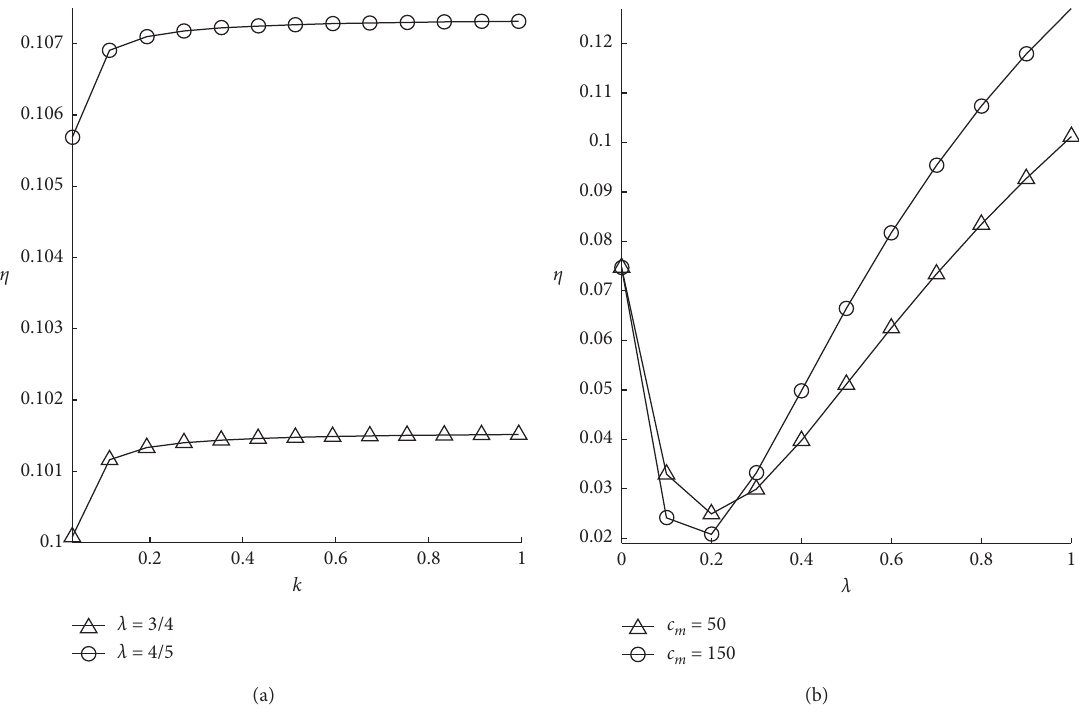
Figure 4: The impact of k and λ on η